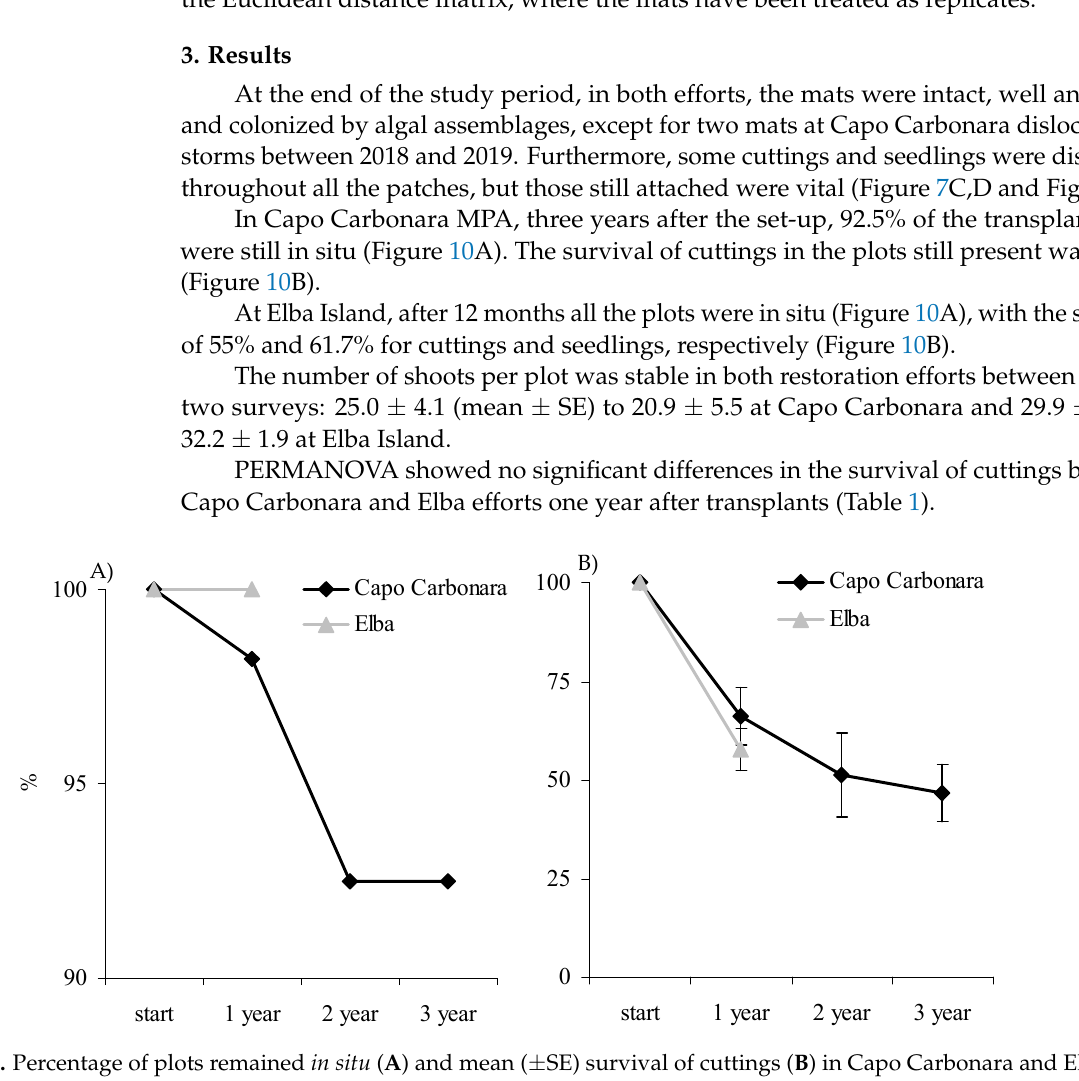
Figure 9. Transplanted seedlings at Elba Island.